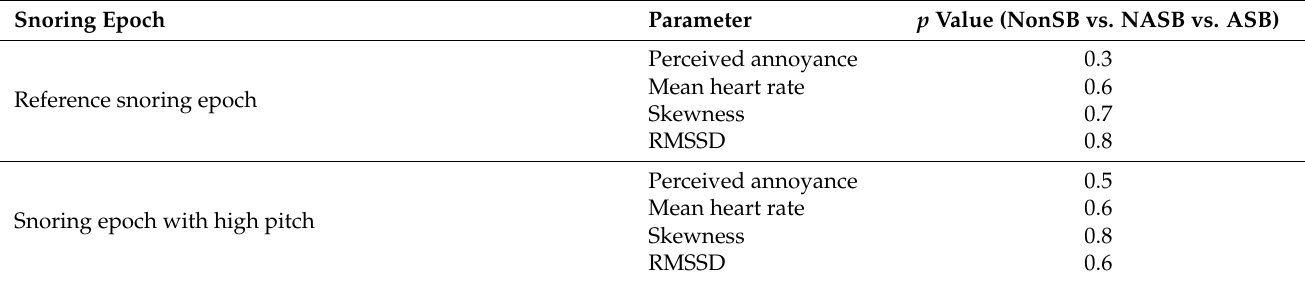
Table 2. The difference in perceived annoyance and heart rate-related parameters between three listener